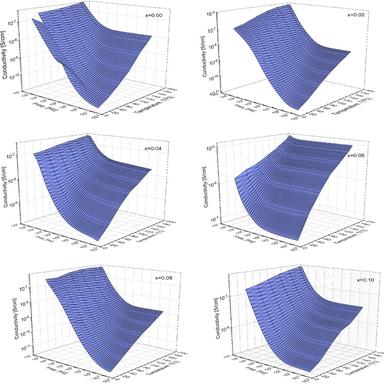
3D plots of ac conductivity of NCZFe2-4xSn3xO4 NSFs as functions of both frequency and temperature.